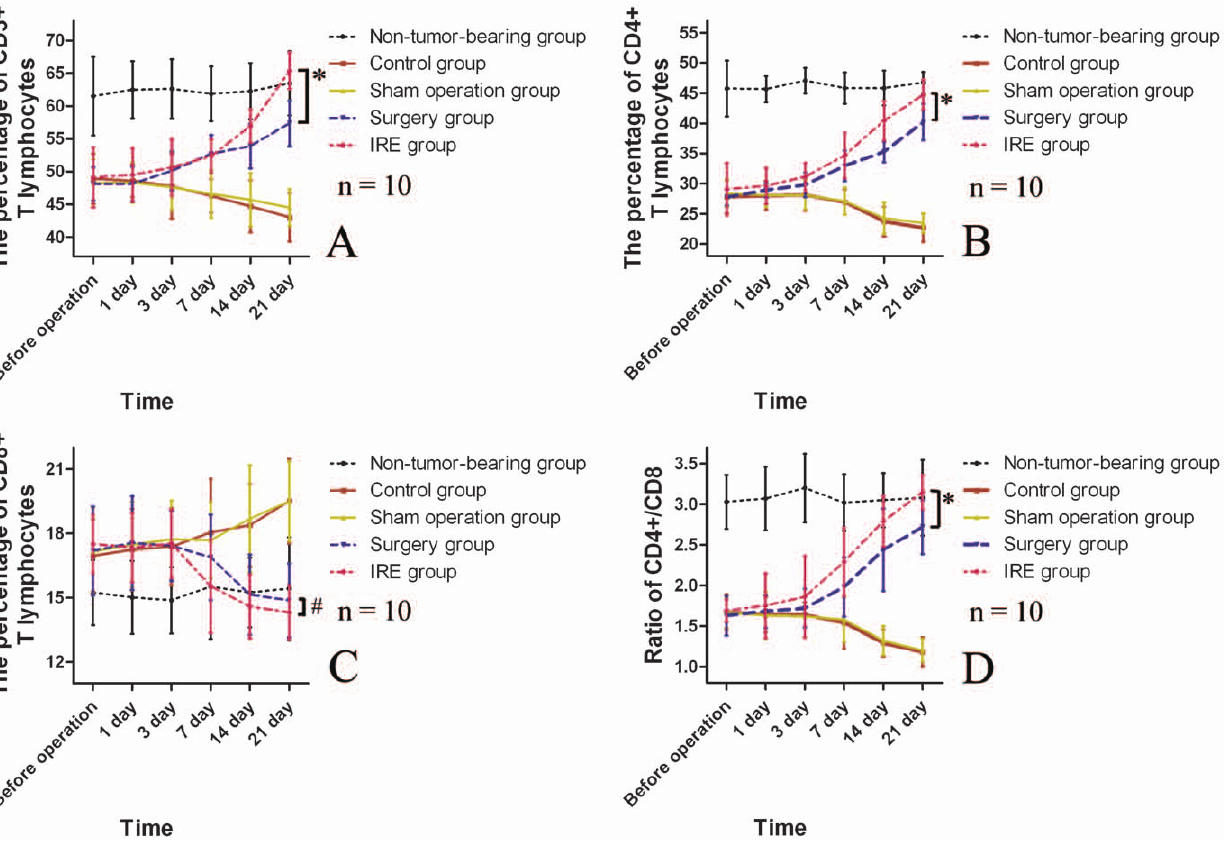
Figure 3. Changes in T lymphocyte subset percentage (A, B, C) and CD4 + /CD8 + ratio (D). *p , 0.05; # p . 0.05.